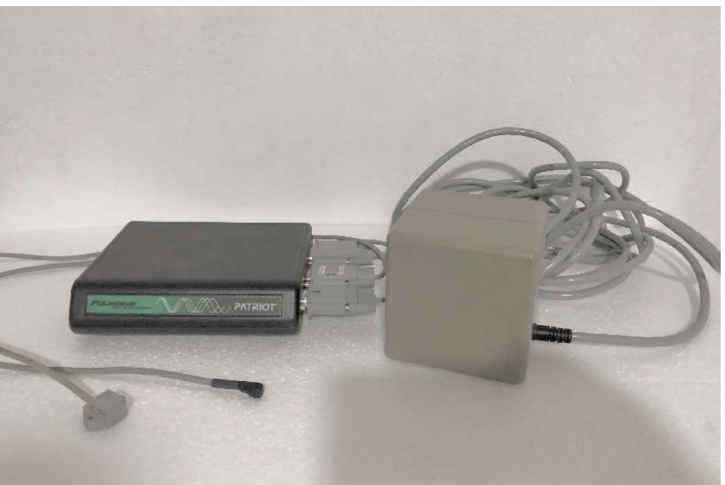
Figure 1. Polhemus system Fastrak. From left to the right: receiver module, two sensors, emitter